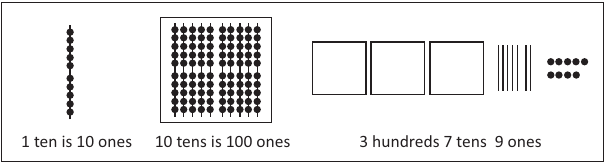
FIGURE 4: Mathematics drawings as a representation of place